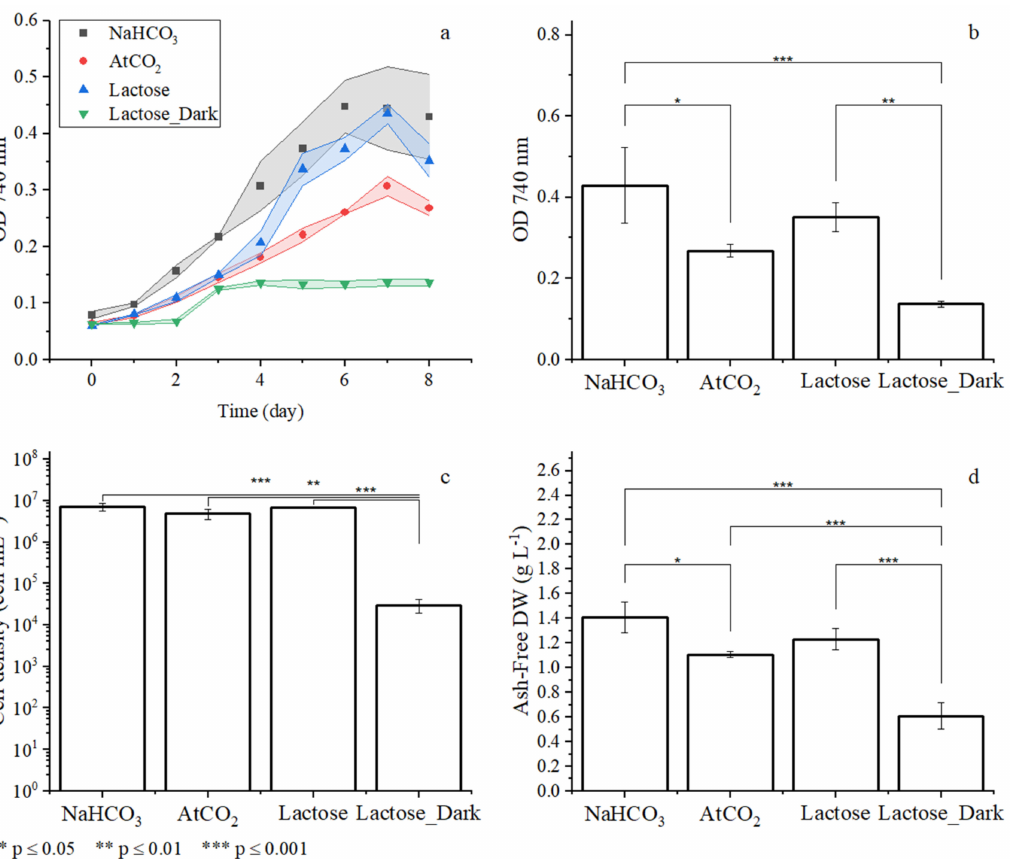
Figure 2. D. tertiolecta growth profile in the preliminary experiment. Growth curve ( a ), optical density ( b ), cell density ( c ), and ash-free dry weight (AFDW) ( d ) at the end of the cultivation